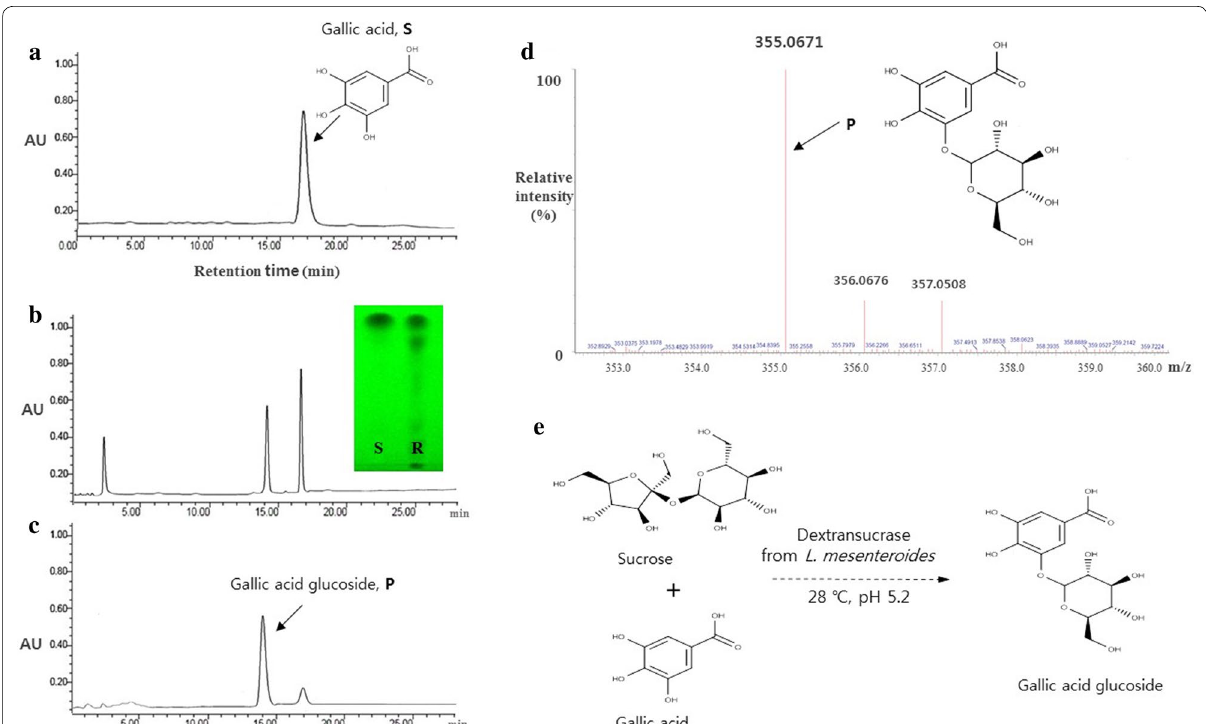
Fig. 1 The schematic diagram of the reaction and HPLC chromatogram of gallic acid glucoside after preparative HPLC. Gallic acid standard (1 mg/ mL) in ethanol ( a ), dextransucrase reaction digest for 6 h ( b ), purified gallic acid glucoside ( c ), MALDI‑TOF MS spectrum of gallic acid glucoside ( d ), and the schematic diagram of the reaction ( e ). S gallic acid, R enzyme reaction mixture of gallic acid, and P final product. Column, TSK‑GEL amide‑ 80, 5 μm (Waters, Milford, MA, USA); mobile phase, acetonitrile/water 80:20 (v/v); flow rate, 1.0 mL/min; room temperature; detection, RID‑10A RI = detector